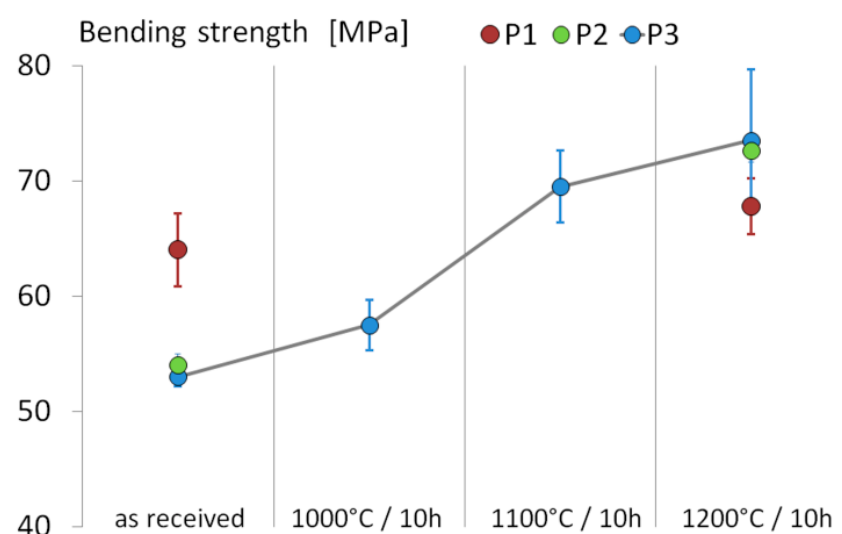
Figure 5. Bending strength for different aging conditions.